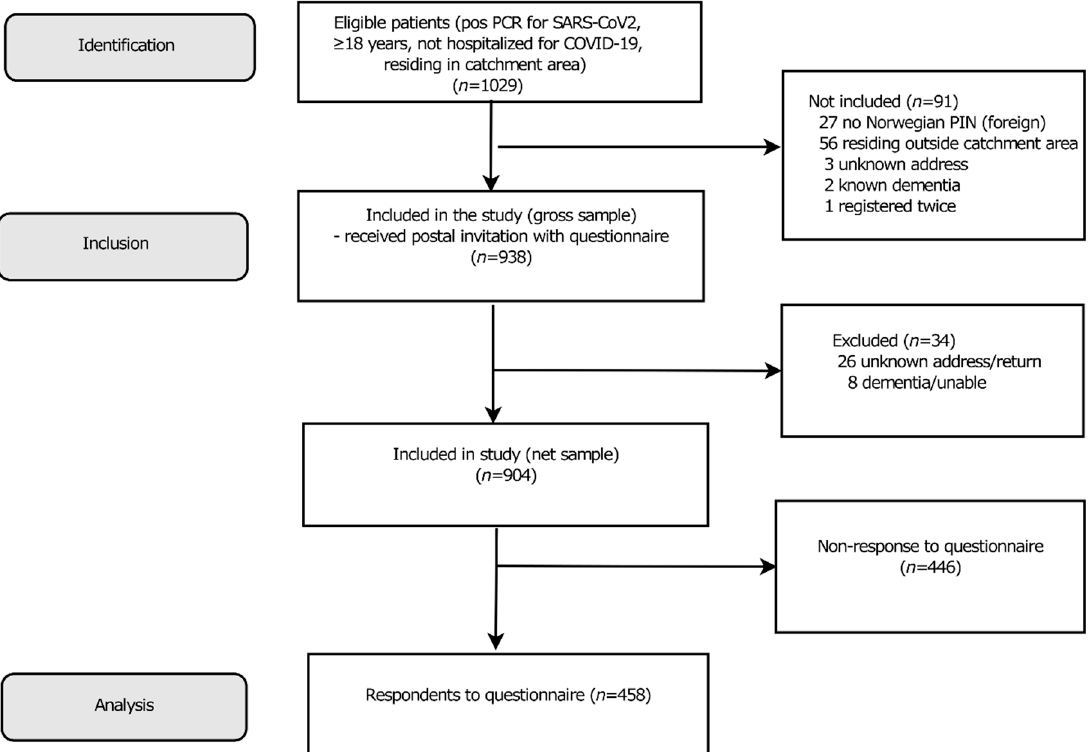
Figure 1. Flow chart showing the selection of the study population.